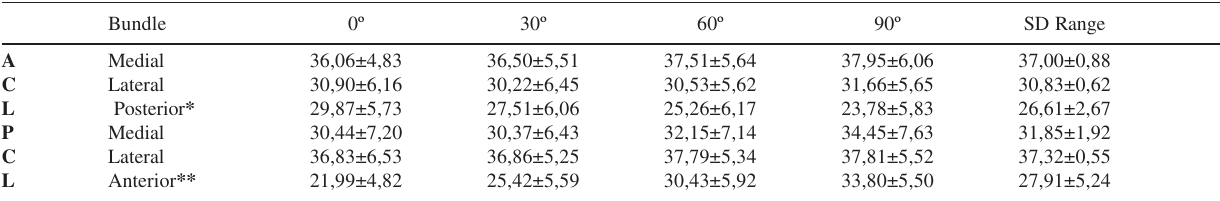
Table 1 - Distribution of data obtained representing the average bundle length change in relation with flexion angles. Bundle 0º